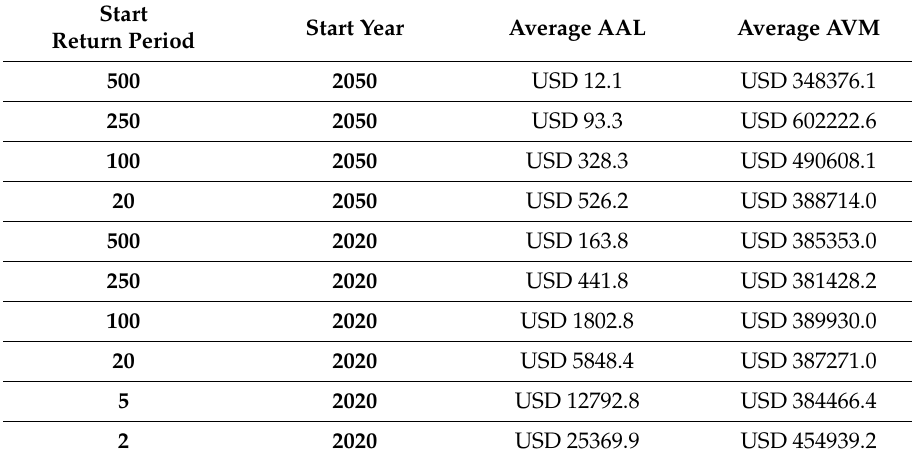
Table 4. The average AAL based on the return period and the year at which property start to flood (Year and return period combinations of flood start year in